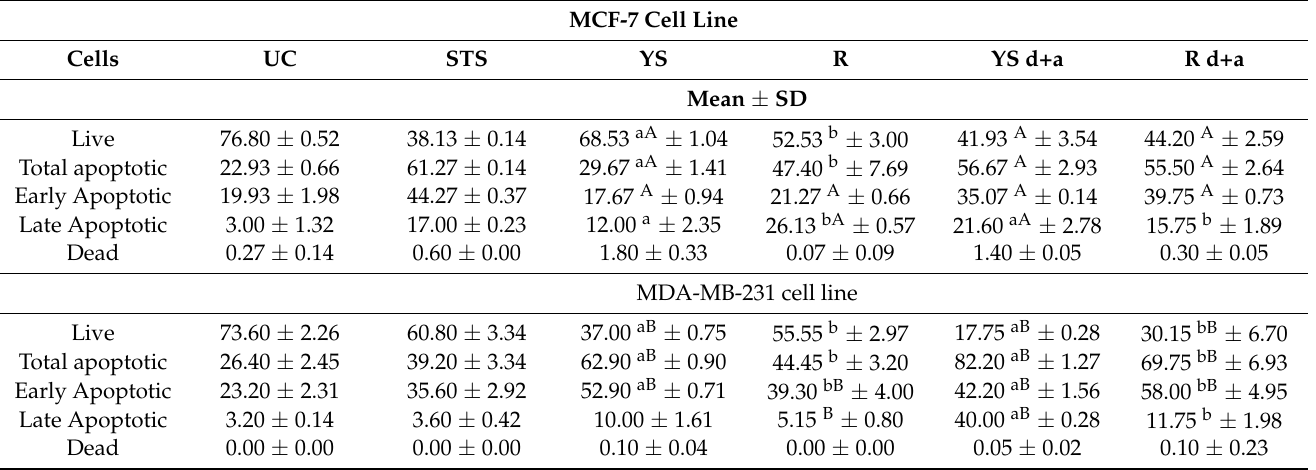
Table 4. Comparison of apoptosis induction in cancer cells [%] using flow cytometry (Muse ® Cell Analyzer).